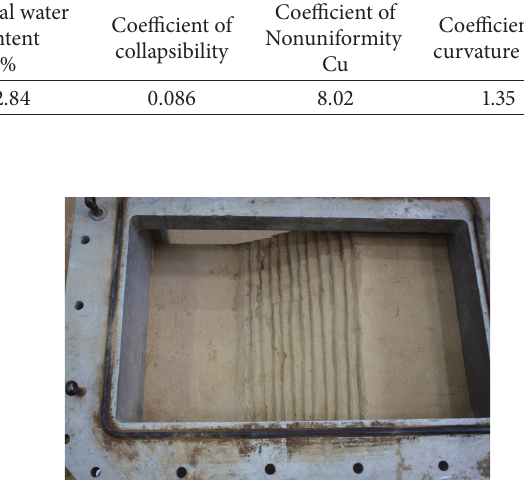
Figure 3: Model pipe pile with sensors